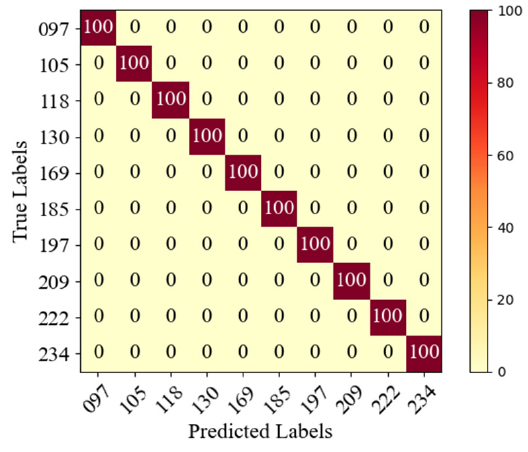
Figure 17. Confusion matrix of the LEG Transformer. Table 5. The results of the testing dataset in different models (%).